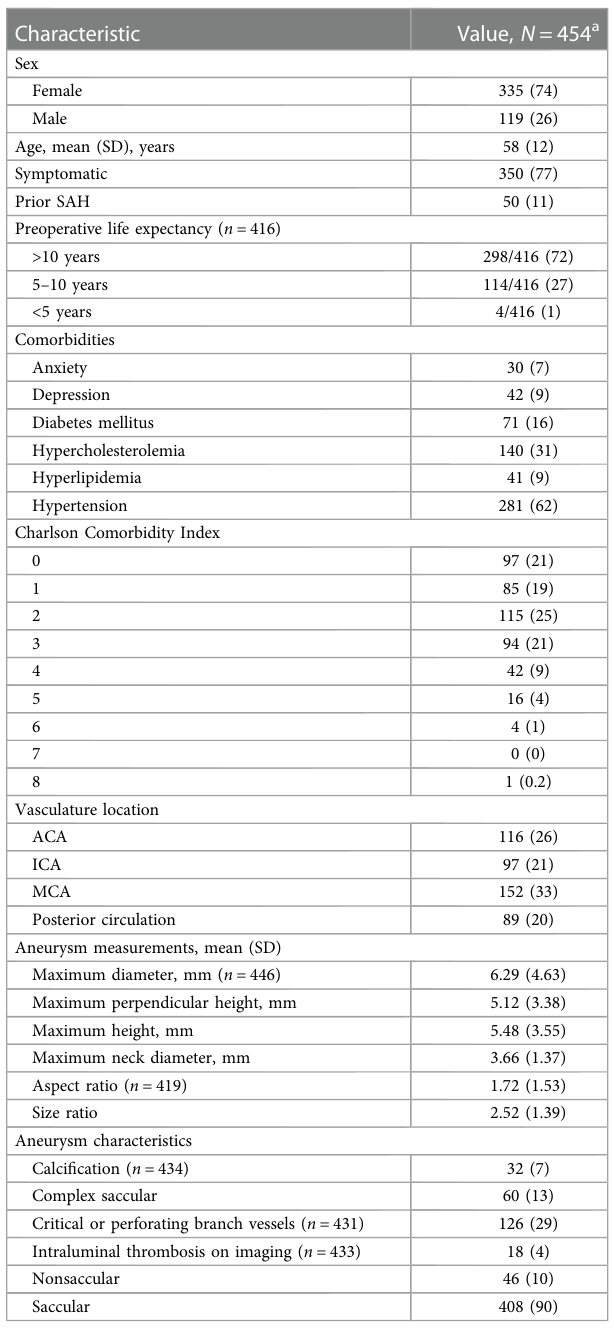
TABLE 2 Presenting symptoms among 454 patients with unruptured intracranial